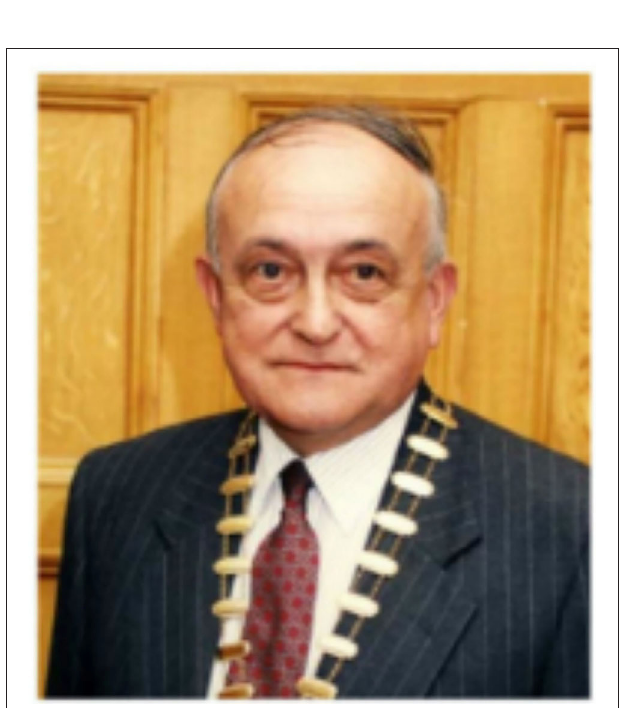
FIGURE 4 | Professor Edward J. Guiney MCh FRCS—University College Dublin,